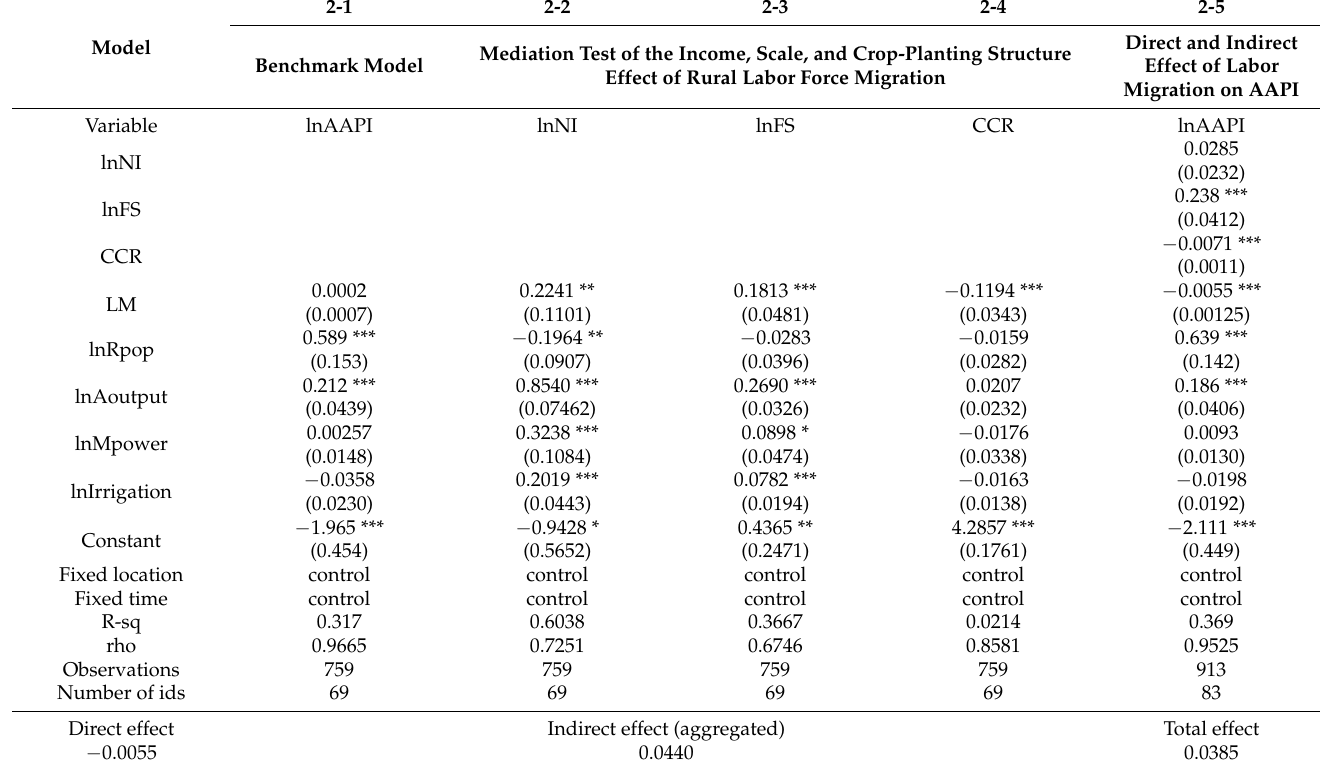
Table 4. Heterogeneity analysis: results of mediating effect model analysis in Hubei